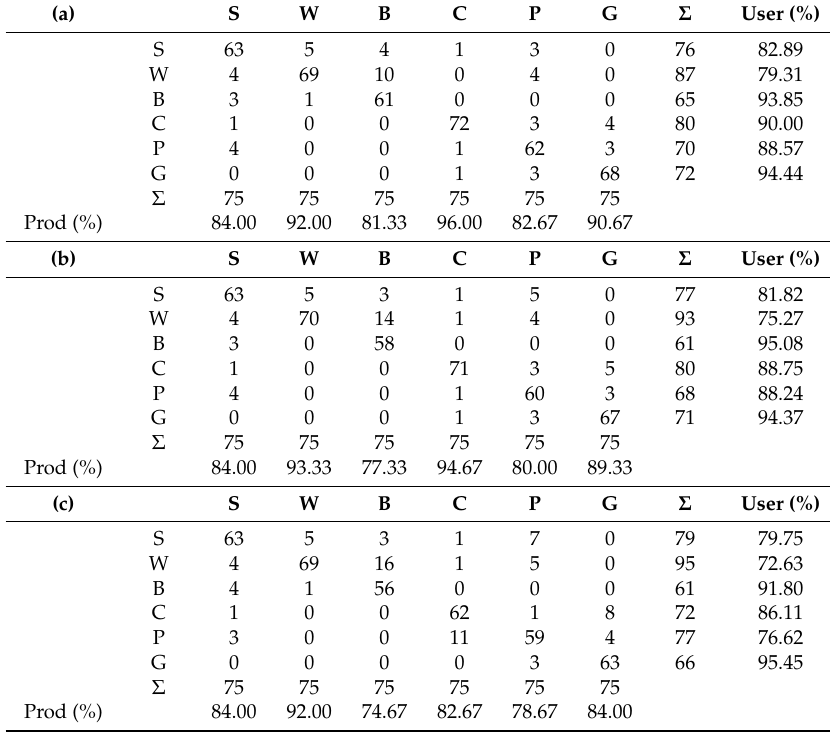
Table 10. Confusion matrices for classifications by the SMLR using training sets containing cases mislabelled to a similar class: ( a ) 5% error; ( b ) 10% error; and ( c ) 20%